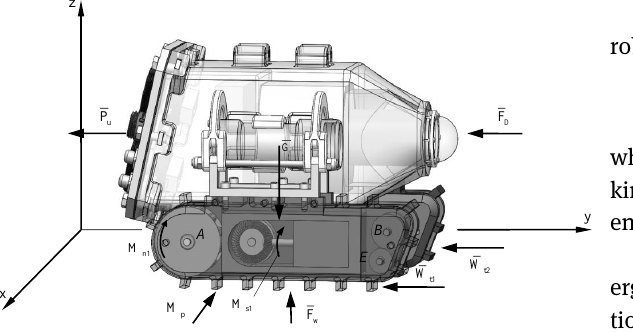
Fig. 4. Forces and moments impacting the robot Figure 4: Forces and moments impacting the